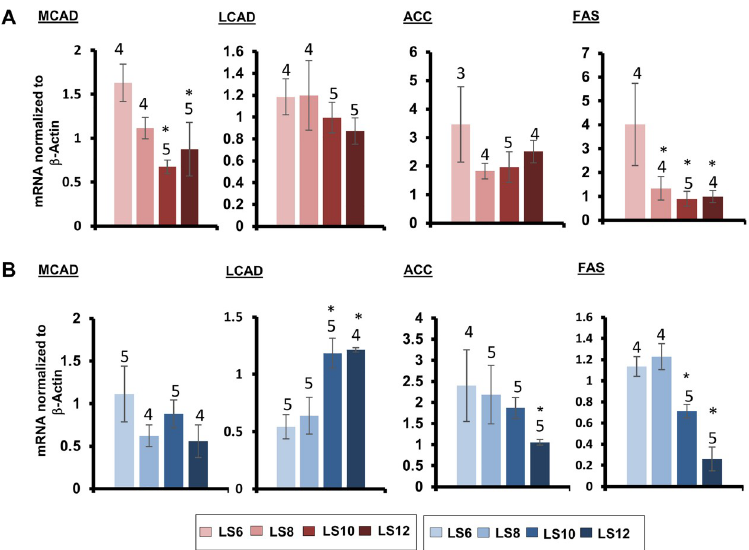
Fig 3. Effect of litter expansion on expression of genes involved in fatty acid metabolism. The mRNA levels of Medium Chain Acyl-CoA dehydrogenase (MCAD) and Long Chain Acyl-CoA dehydrogenase (LCAD), genes involved in fatty acid break down, and Acetyl CoA Carboxylase (ACC) and Fatty Acid Synthase (FAS) genes involved in biosynthesis were measured in the gonadal fat of female (A) and male (B) mice from various litter sizes at 15 months of age. Data represented are the mean ± SEM from 3–5 mice per group. All groups were compared to control LS6 and were statistically analyzed by one-way ANOVA with Tukey’s and FDR with Benjamini & Hochberg multiple correction test ( � p <